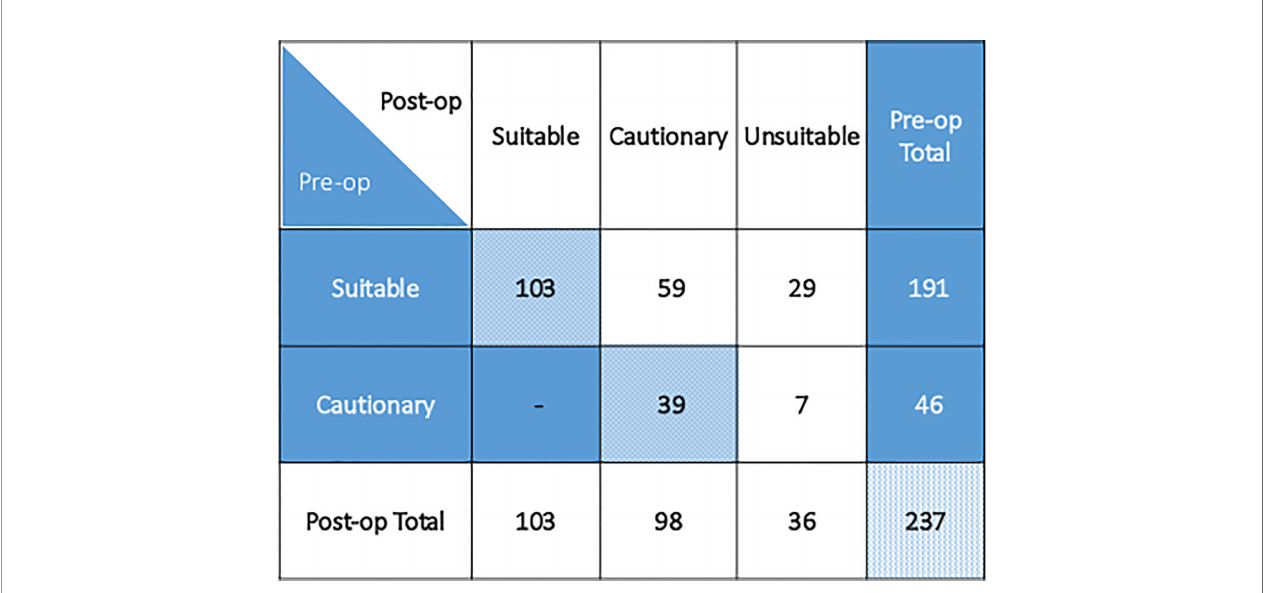
FIGURE 1 | Patient preoperative and postoperative group suitability classi fi cation as per 2017 ASTRO APBI consensus